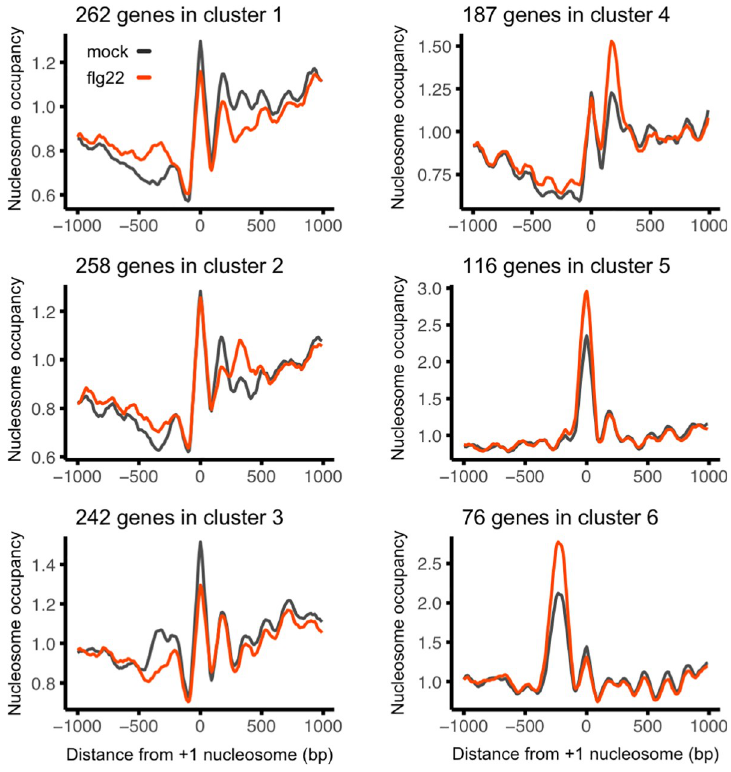
Fig 2. flg22-induced changes in nucleosome remodeling follow distinct patterns of nucleosome repositioning. K- means clustering of differential nucleosome occupancy. 1,142 flg22-induced genes with Differentially Positioned Nucleosomes (DPNs) were clustered in 6 groups with marked differences in average nucleosome occupancy between flg22 elicitation (red) and mock treatment (black). The graph is centred on the +1 nucleosome from the gene TSS.